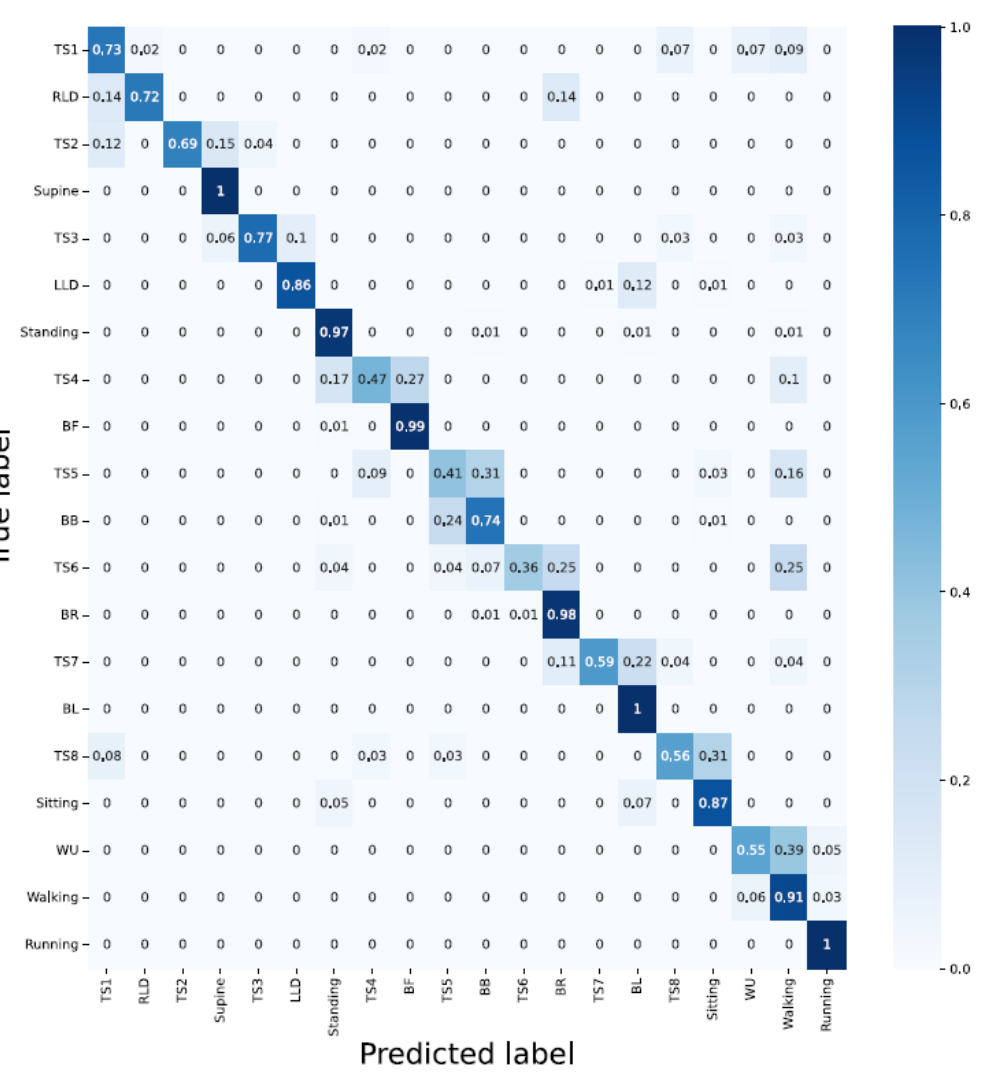
Figure 13. CNN architecture with the data fusion and PCA applied for two-second